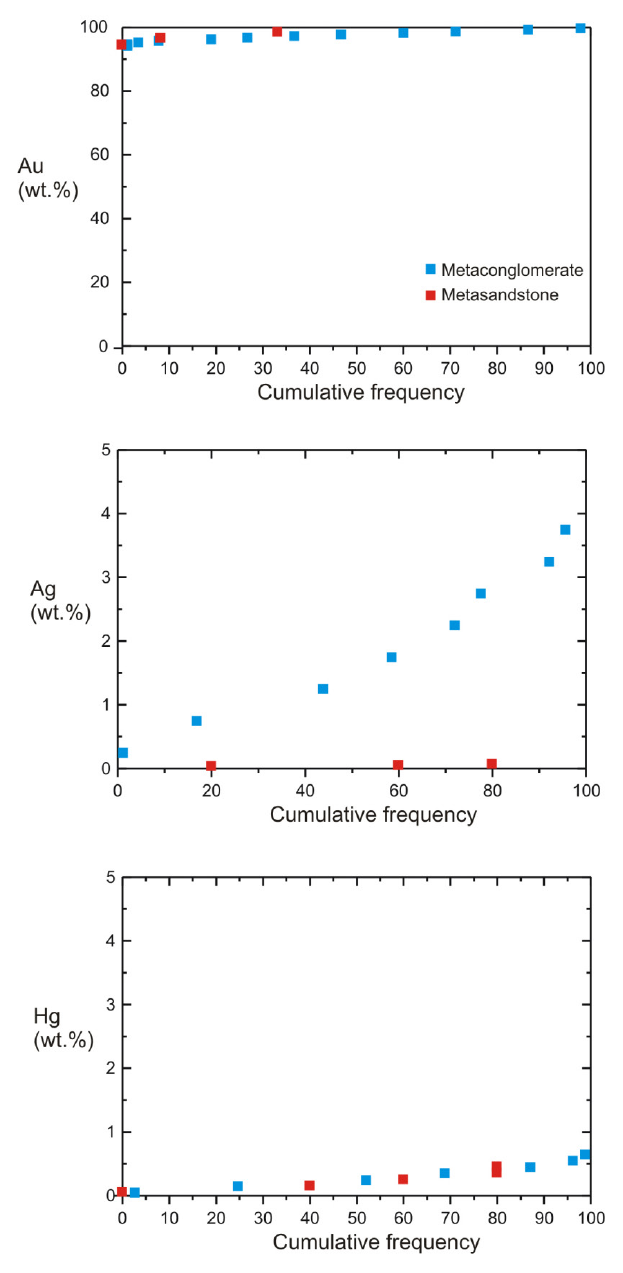
Figure 14 - Cumulative frequency diagrams of Au, Ag and Hg compositions in gold partivles from metaconglomerate and